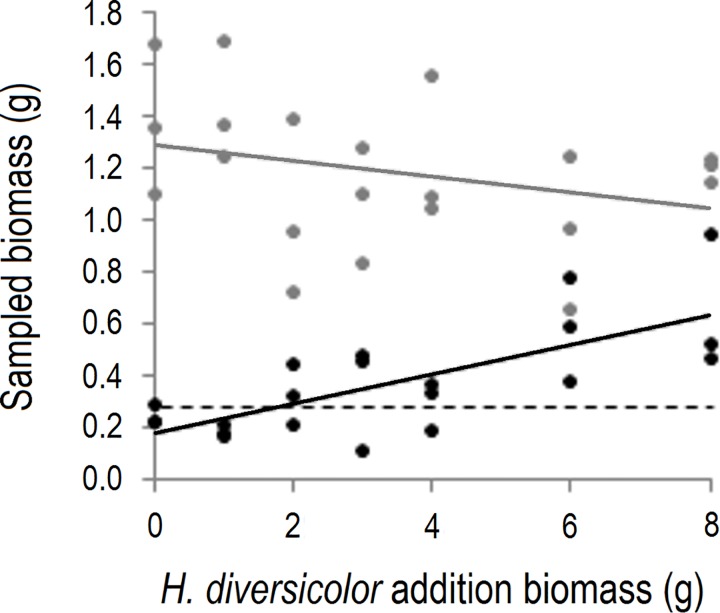
Transplants successfully raised the density of H. diversicolor beyond the ambient density.Variation in the sampled biomass (12 days after experiment initiation) of Hediste diversicolor (black; linear regression, R2 = 0.59) and Corophium volutator (grey; linear regression, R2 = 0.09) in relation to the addition biomass of H. diversicolor in field plots. The dashed line marks the maximum density of H. diversicolor recorded in plots with no experimental additions.